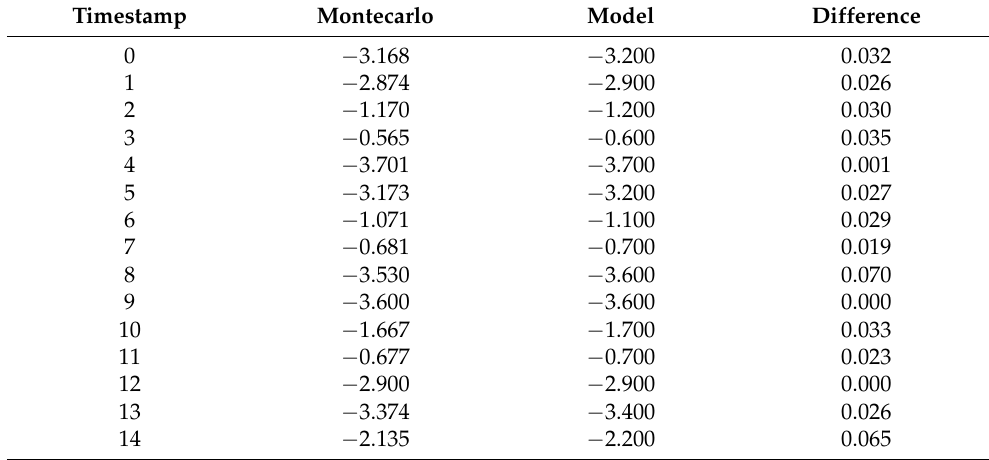
Table 3. Results of temperature (°C) value obtained before and after the application of Monte Carlo methods.